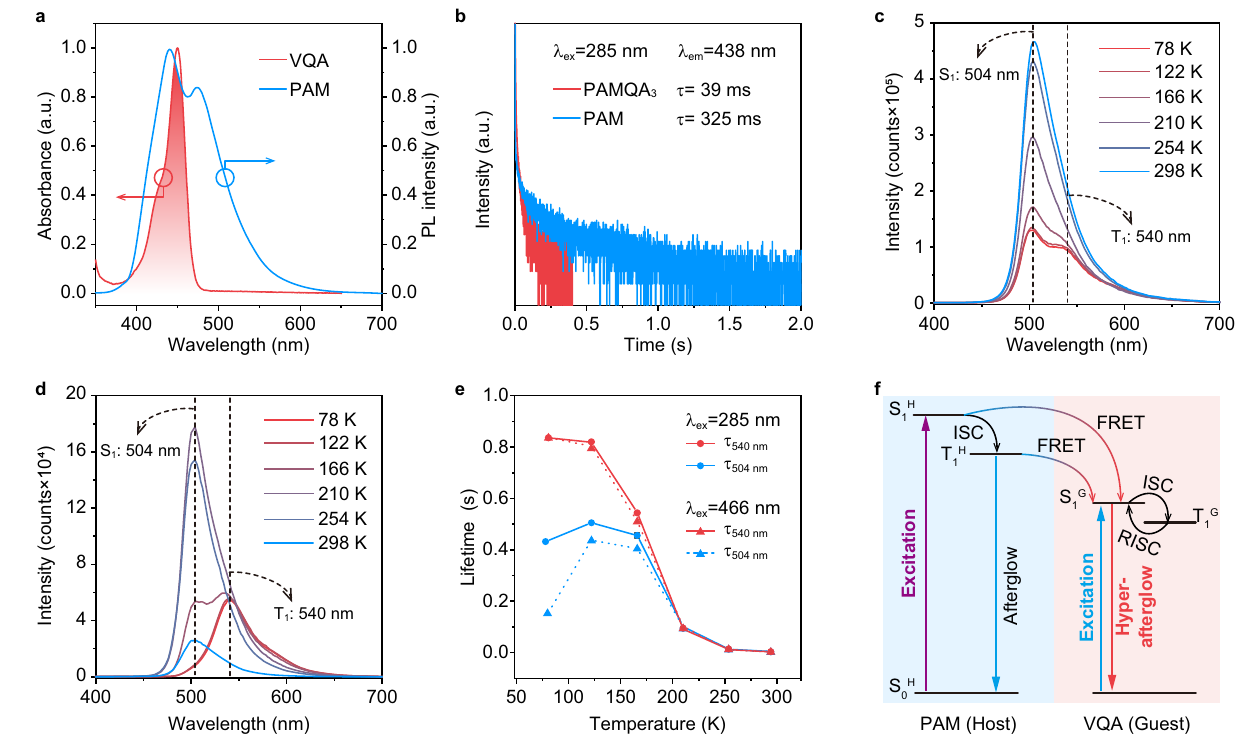
Fig. 3 | Mechanism investigations of hyperafterglow emission. a Delayed PL spectrum (10ms delay) of PAM fi lm and absorption spectrum of VQA solution. b Lifetime decay pro fi le of emission band at ~438nm of PAM and PAMQA 3 fi lms under 285nm UV light excitation. c , d Temperature-dependent SSPL ( c ) and delayed PL (10ms delay) ( d ) spectra from 78 to 298K of PAMQA 3 fi lm.